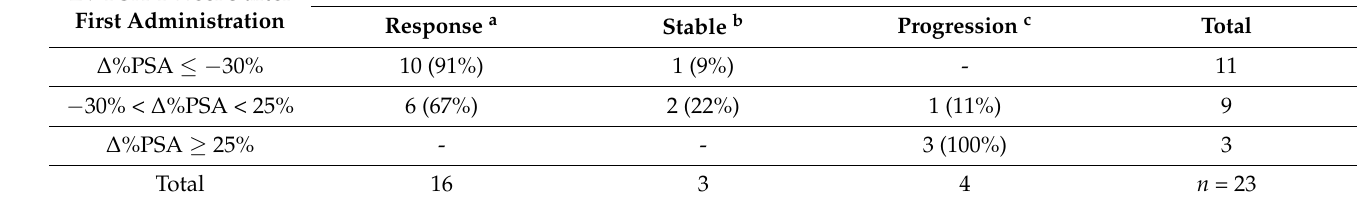
Table 2. Correlation between early PSA change ( ∆ %PSA) four weeks after first administration of PSMA-RLT (baseline) and biochemical response at restaging after 2 cycles using a threshold of early PSA decrease of 30% to baseline ( ∆ %PSA ≤ −